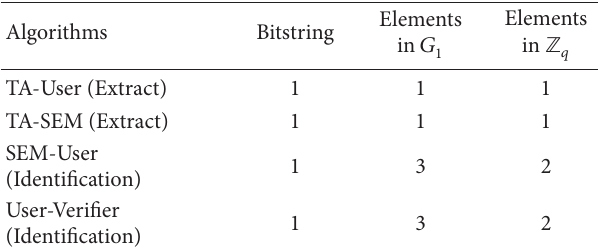
Table 2: Communication costs between algorithms for the GQ-SM- IBI scheme.